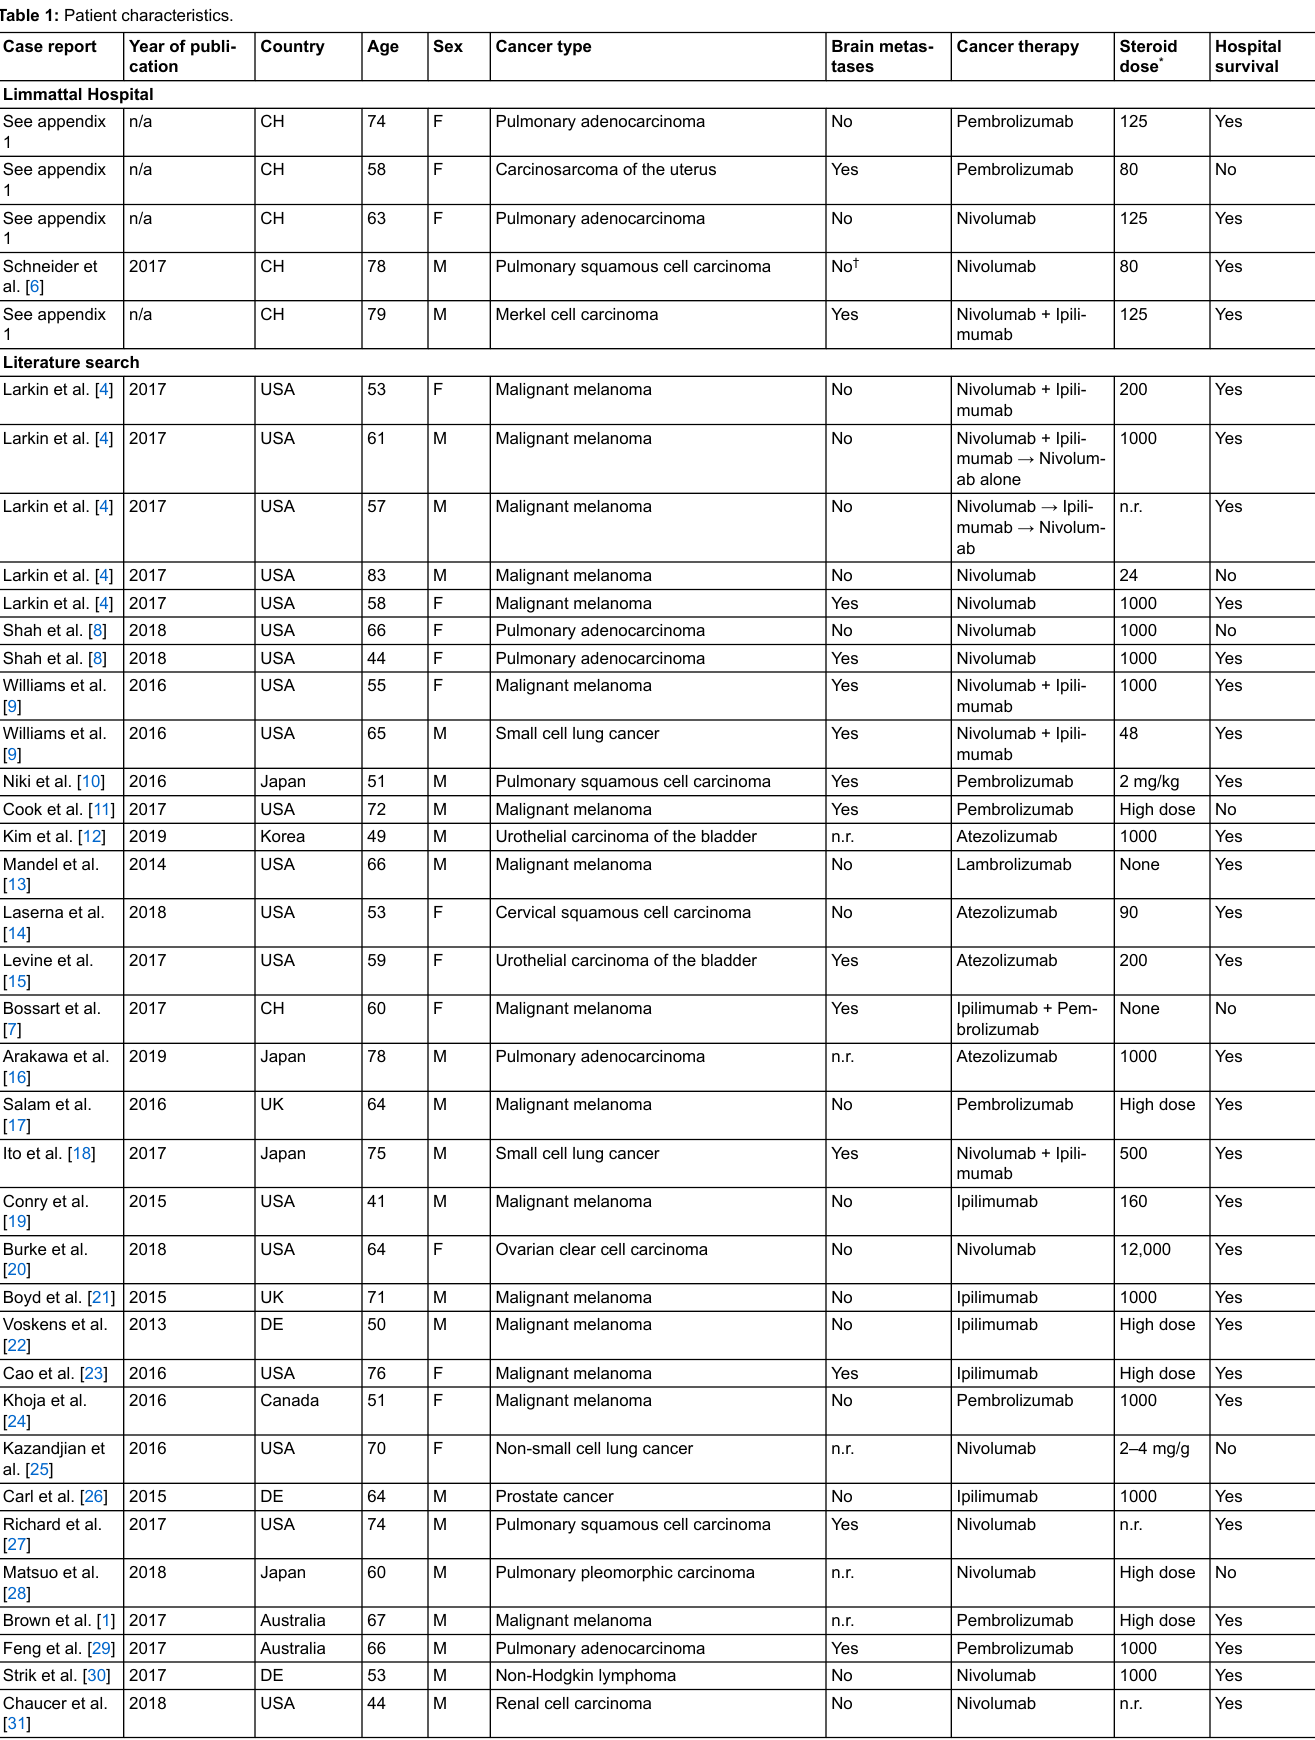
Table 1: Patient characteristics. Case